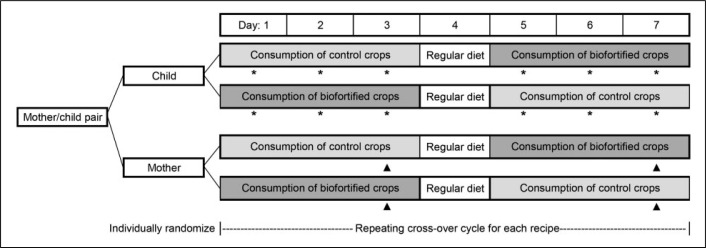
Study design for mother–child pairs separately, individually randomized to a crossover evaluation of biofortified and control crops. For each recipe, participants evaluated the recipe made from either control or biofortified crops for 3 days, had a 1 day break without feeding, then switched to the opposite crop variety. Child’s food intake was weighed each day (*). Mother’s hedonic scale was evaluated on the last day of each recipe variety (days 3 and 7, ▲). This cycle repeated for each recipe evaluated.